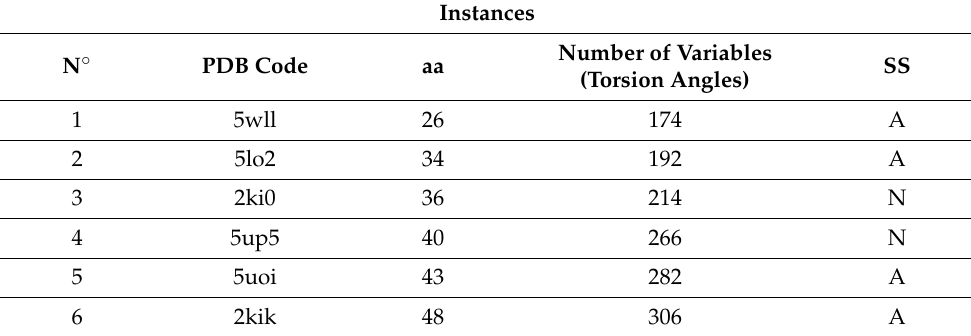
Table 3. Mini-proteins.